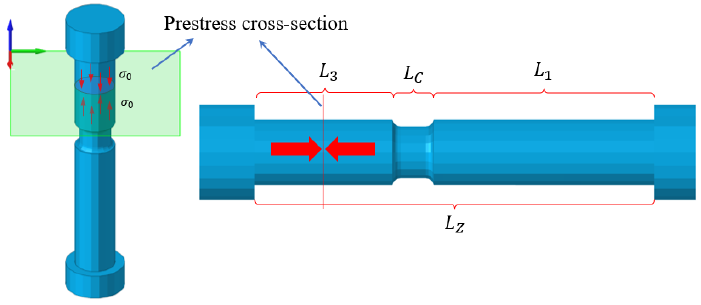
Figure 11. Preload force application process.